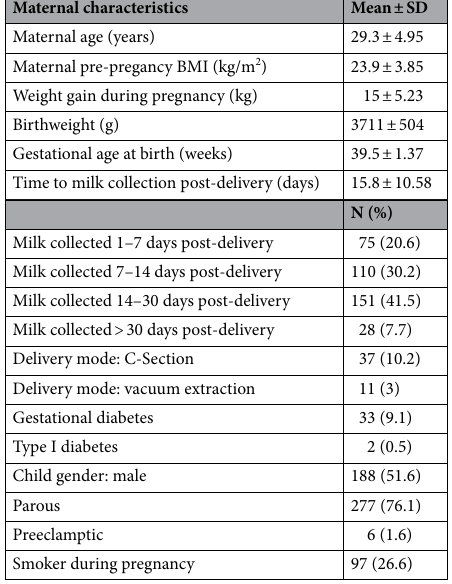
Table 1. Characteristics of study population (n =